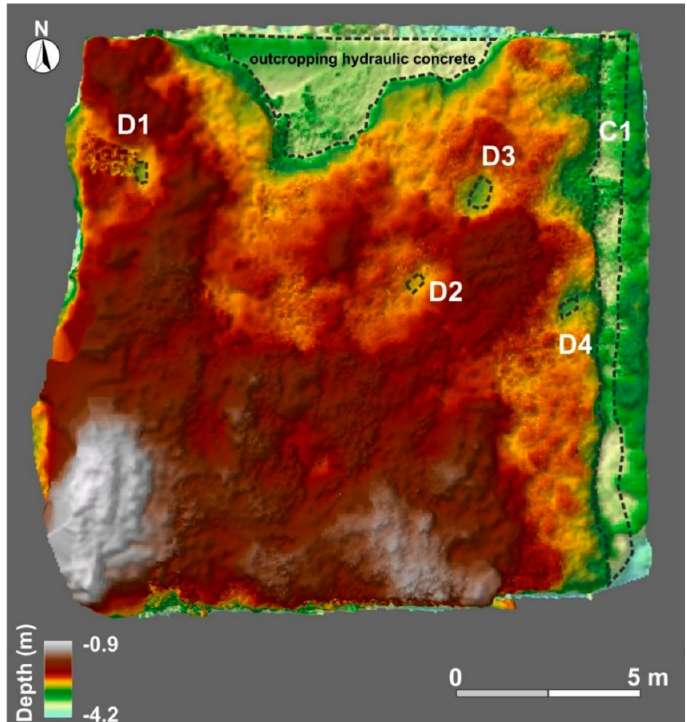
Figure 21. Three-dimensional reconstruction of the upper surface of the more preserved pila (pilaDTM) with the traces of the oaken stakes ( catenae and destinae ) composing the cofferdam (light-dark dashed line).